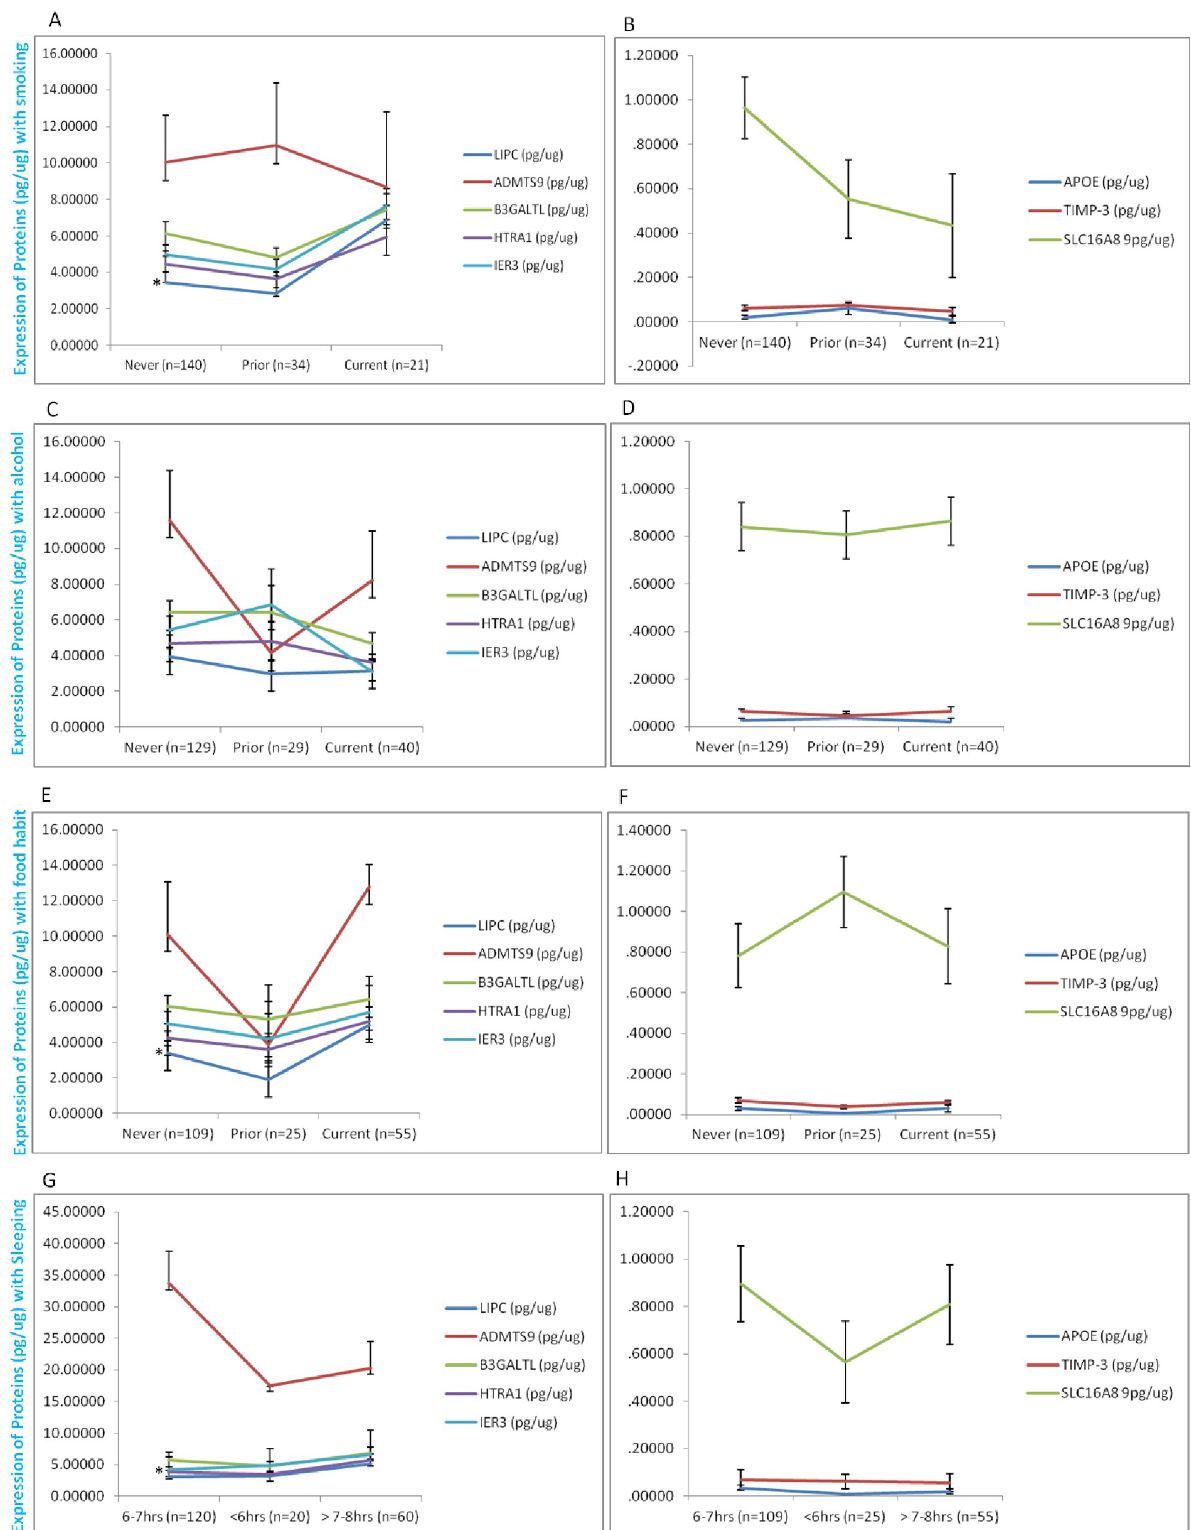
Fig 1. Expression of protein under ADL. Expression of lipid metabolizing (LIPC and APOE), proagniogenic (TIMP3 and ADAMTS9), regulatory (HTRA1, B3GALTL, and IER3) and momocarboxylic acid transporter (SLC16A8) proteins under the influence of ADL. LIPC (pg/ug) levels were